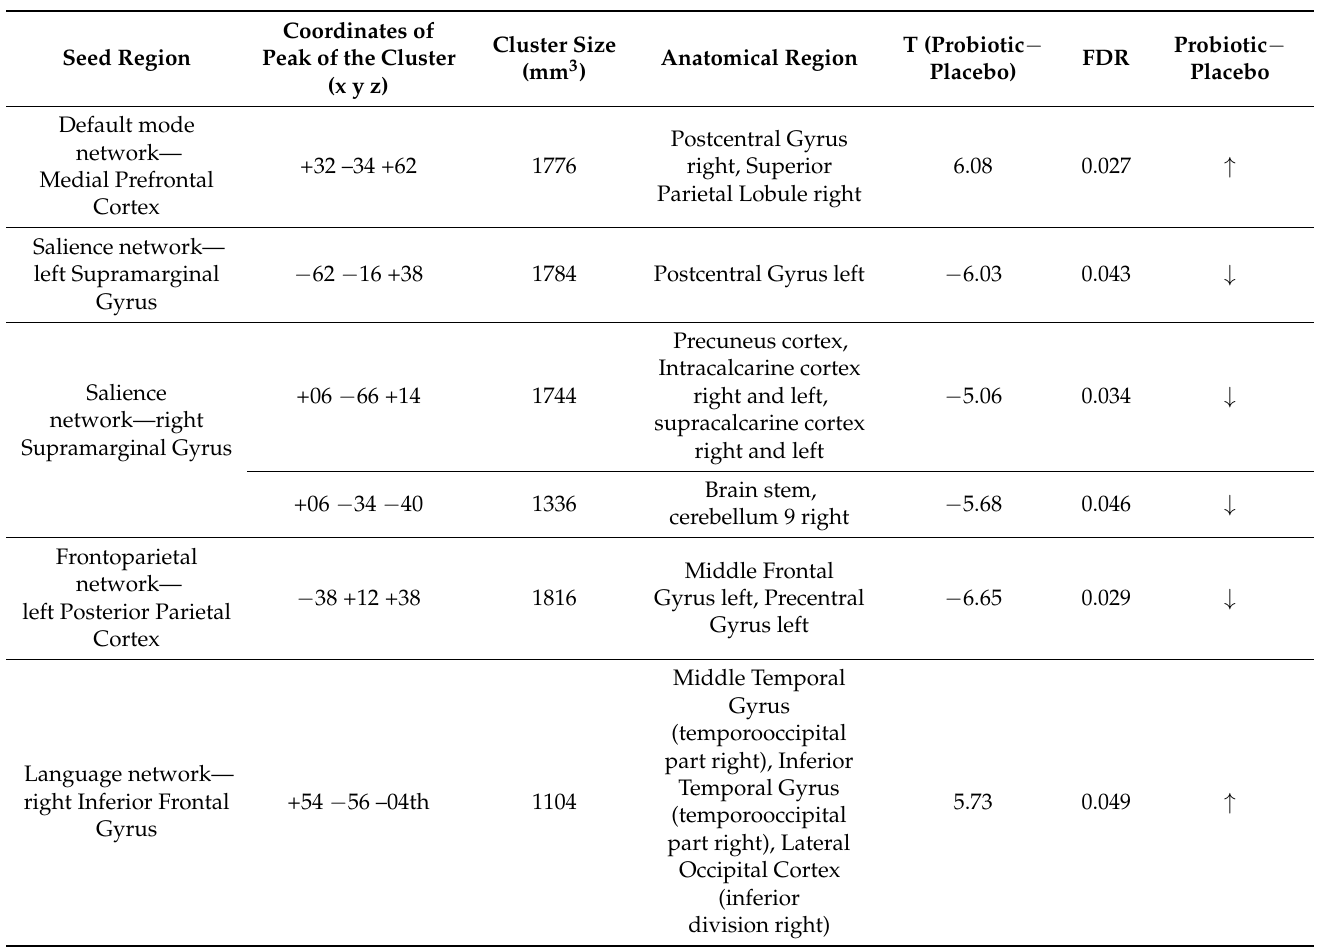
Table 1. Resting state functional connectivity. Clusters that were found to be associated with significant changes in functional connectivity between both of the interventions during resting state. All other seed regions within the default mode network, salience network, dorsal attention network, frontoparietal network, cerebellar network, sensorimotor network, visual network and language network did not show significantly different connectivity with any other part of the brain. Upward arrows indicate increased and downward arrows indicate decreased resting state functional connectivity after the probiotic compared to the placebo intervention. (Seed-to-voxel